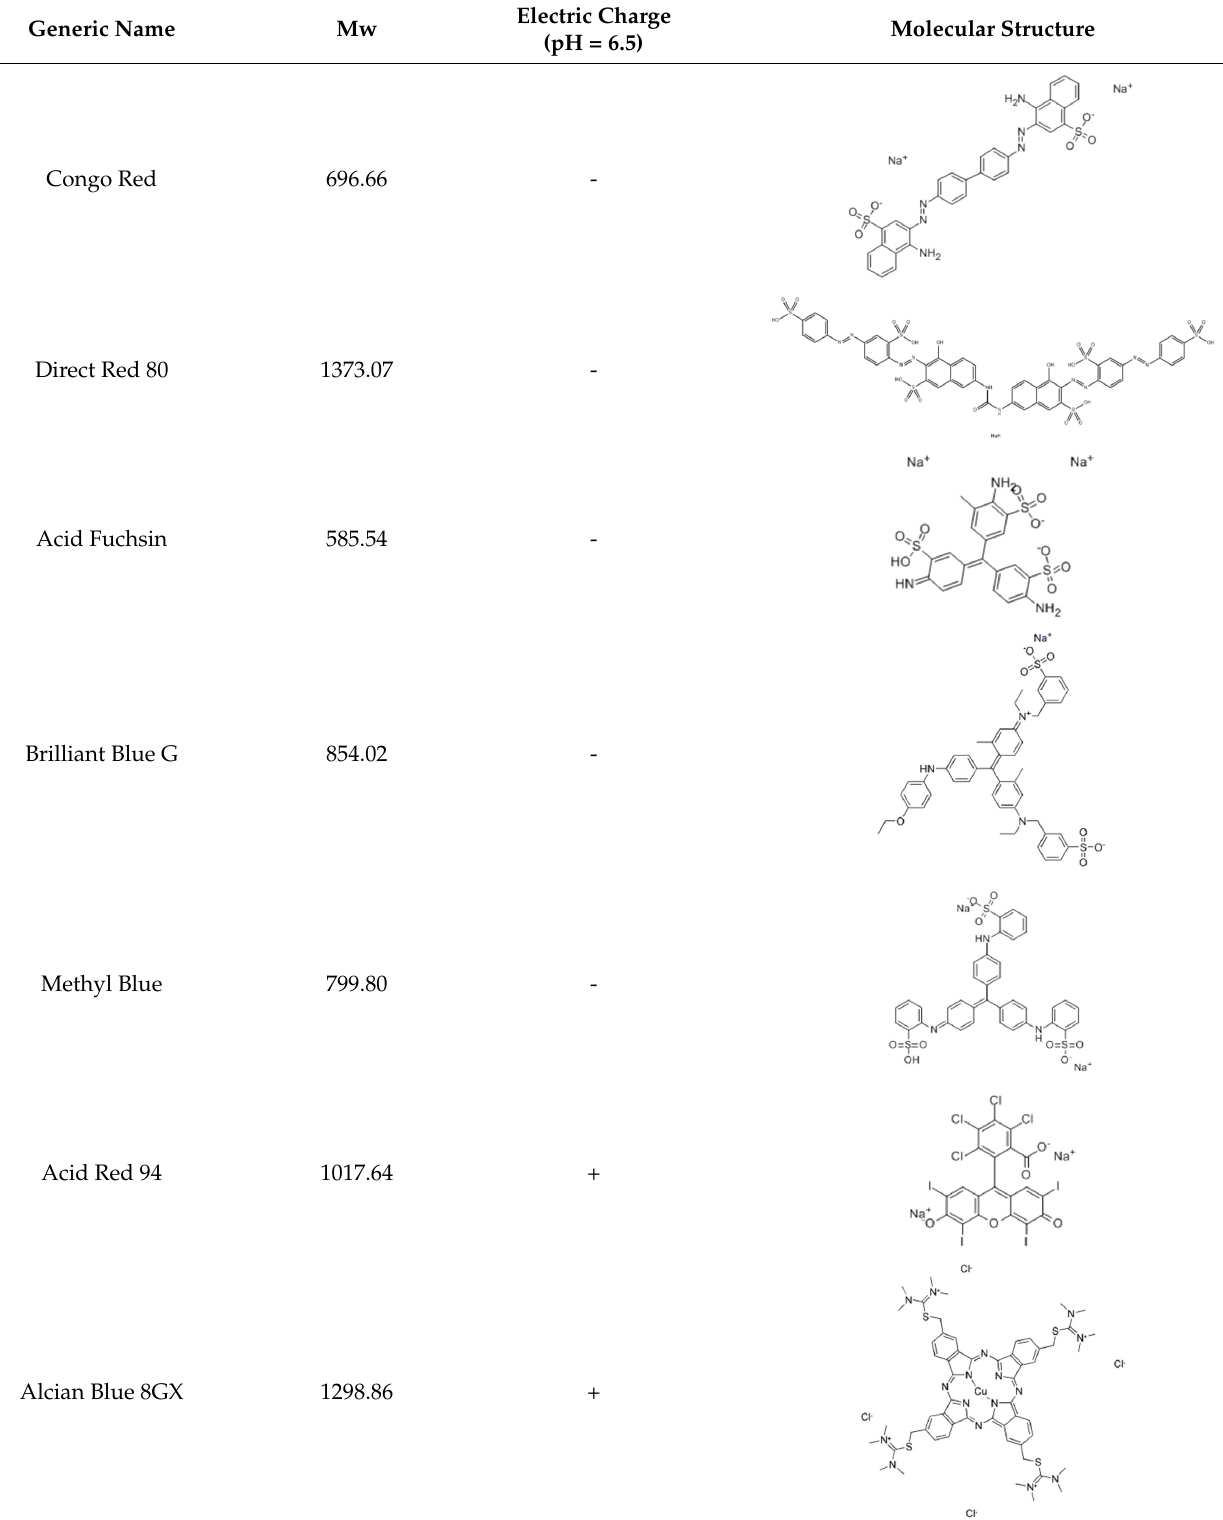
Table 2. Characteristics and structures of the dyes used in this study.